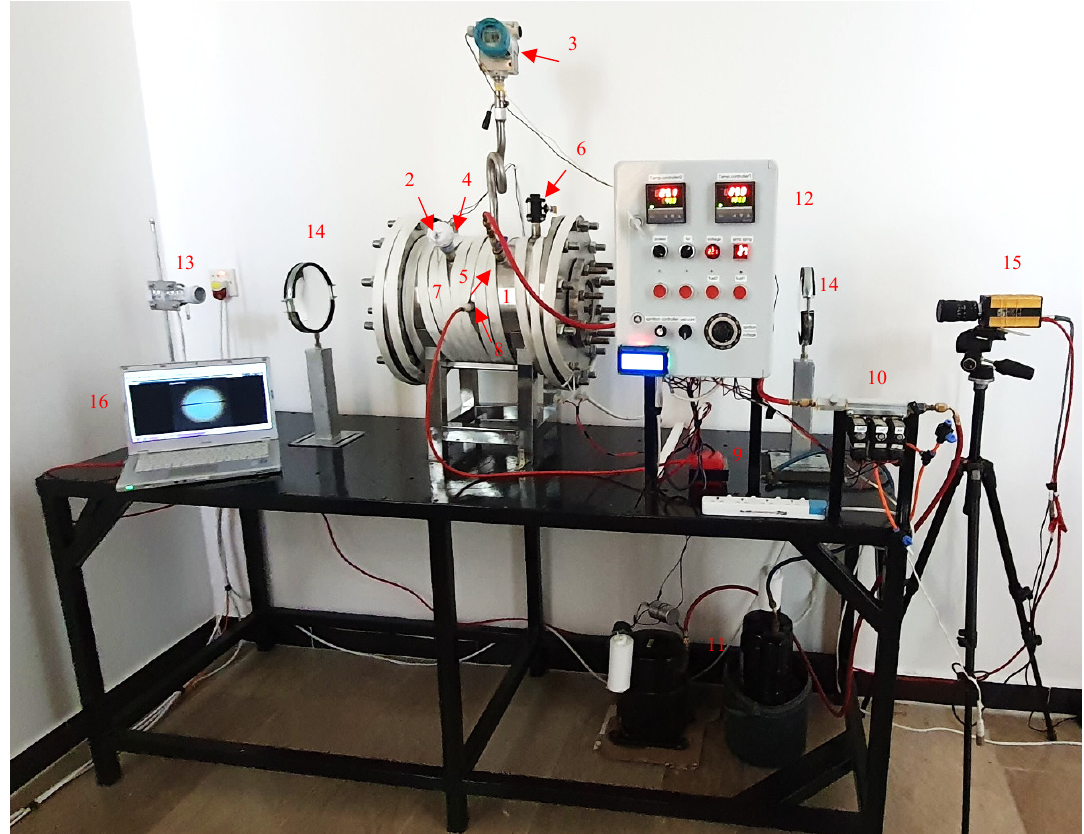
Figure 1. Photograph of the experimental apparatus used in the study. (1) Combustion chamber, (2) Thermocouple, (3) Pressure transmitter, (4) Liquid fuel injection valve, (5) Inlet valve, (6) Exhaust valve, (7) Electrical heating tape, (8) Sparking ignition electrodes, (9) Ignition burner transformer, (10) Injection unit, (11) Vacuum pump, (12) Electrical control board unit, (13) Light Source, (14) Two lenses (15) High-speed camera, and (16) PC computer.